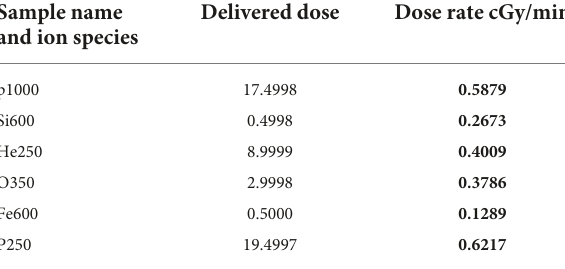
TABLE 1 The particles used in the 5-beam galactic cosmic rays (GCR) spectrum along with their respective doses and dose